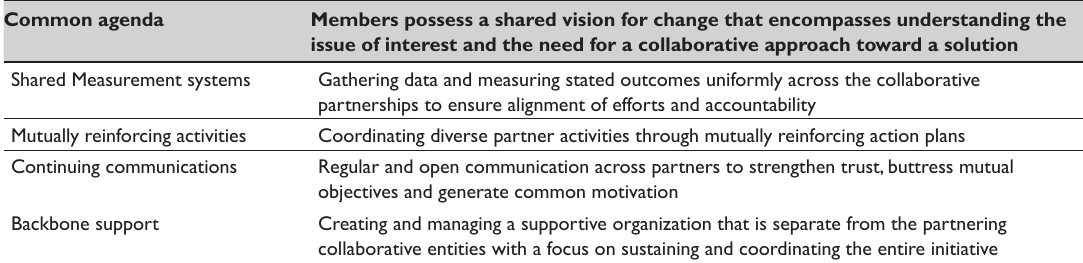
Table 1: Core Pillars of CI Common agenda Shared Measurement